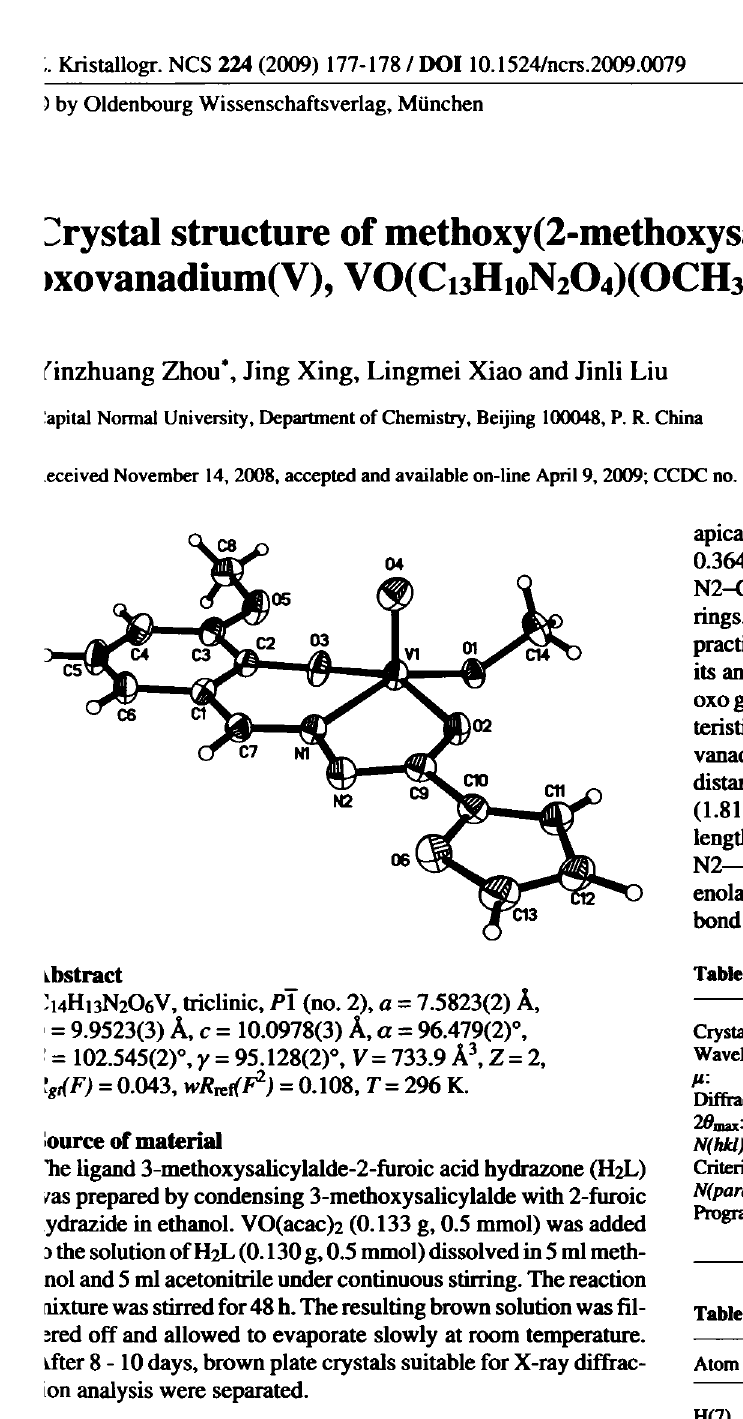
Table 2. Atomic coordinates and displacement parameters (in A 2